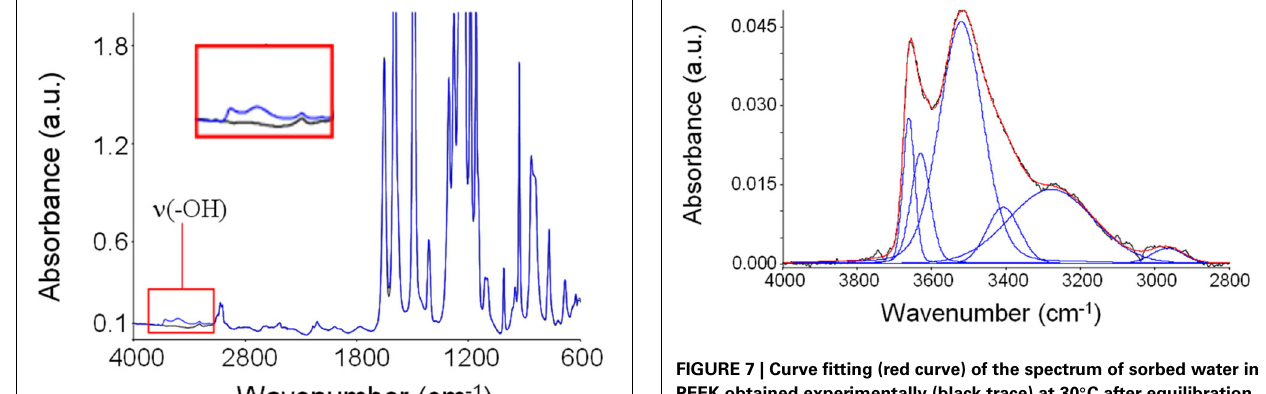
FIGURE 7 | Curve fitting (red curve) of the spectrum of sorbed water in PEEK obtained experimentally (black trace) at 30 ◦ C after equilibration with water vapor at p / p 0 = 0 . 75. The detected components are reported in blue.